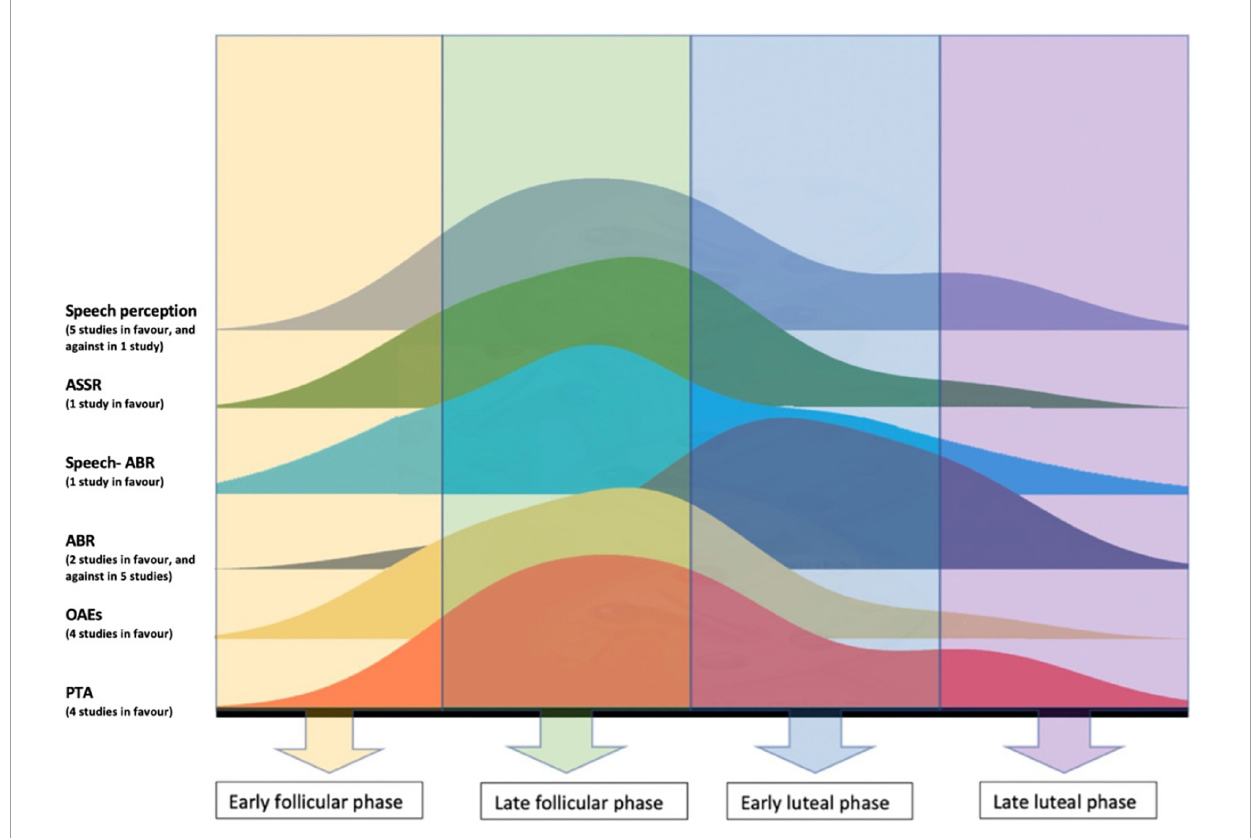
FIGURE3 Illustration of the fluctuation of the audiological performances across the menstrual cycle, the peaks represent better